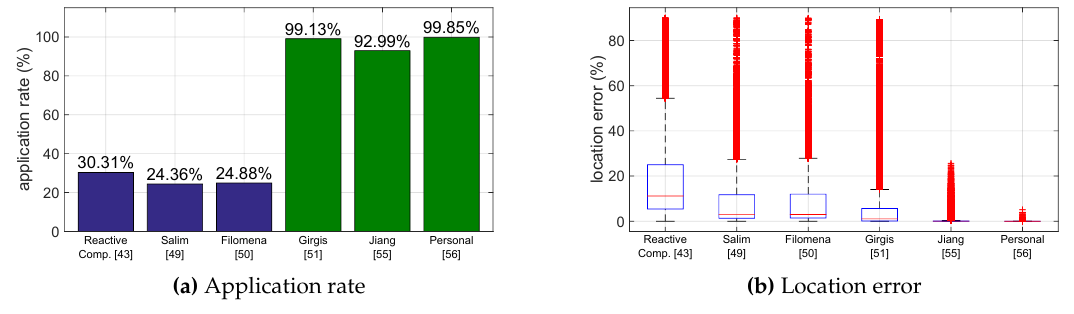
Figure 11. Global analysis results.